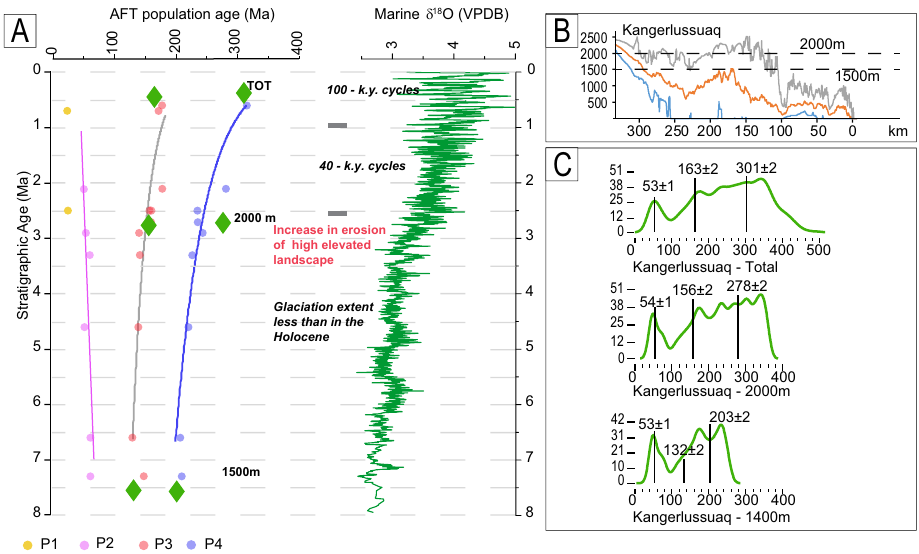
Figure 4. ( A ) AFT population age lag time for ODP sites 987 and 918 compared to a global δ 18 O curve 8 . Samples show P1 and P2 populations, which get younger moving upwards, whereas P3 and P4 show an increasing age towards the younger stratigraphic age. P3 and P4 trends over time mimic the δ 18 O curve, suggesting a climatic control in the detrital AFT signal. Measured population ages are compared with synthetic ages obtained from the Kangerlussuaq drainage area, which is reduced in elevation to test the increasing contribution of the sediment obtained from a high elevated landscape. ( B ) Swath profile of Kangerlussuaq: the profile starts from the coast line towards inland; lines represent minimum, mean and maximum elevations; dotted lines indicate the elevation at which the DEMs are clipped. ( C ) Synthetic probability distribution and age of populations obtained from drainage areas reduced to 2000 and 1500 m in